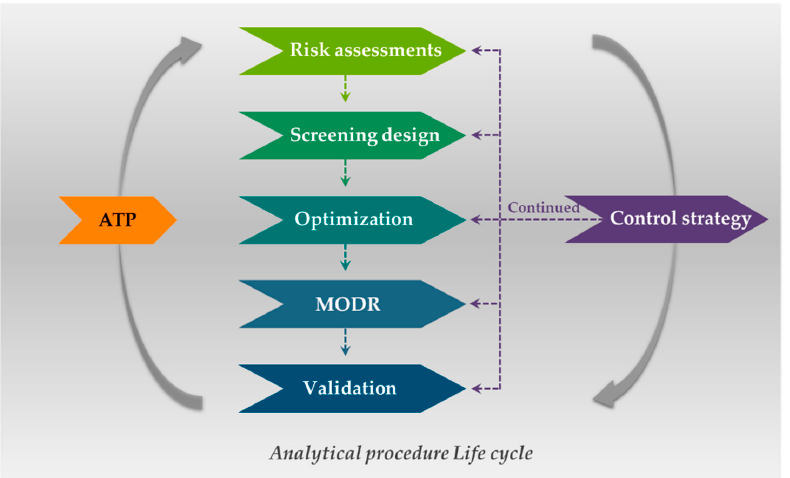
Figure 1. Schematic representation of the steps of the AQbD process: Analytical target profile (ATP), risk assessments, screening design, optimization, method operable design region (MODR), analytical procedure validation, and control strategy.